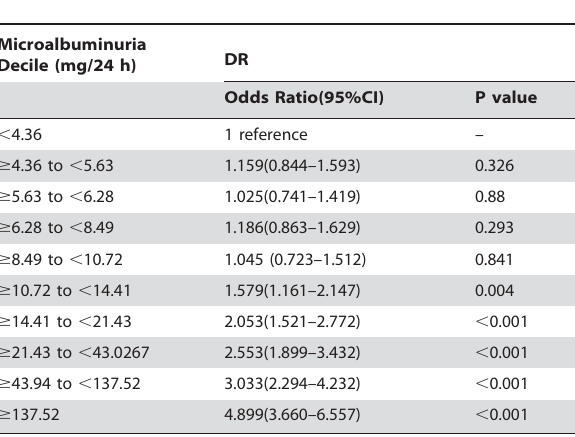
Table 3. Microalbuminuria Deciles as Risk Factors for diabetic retinopathy in 4,739 diabetes